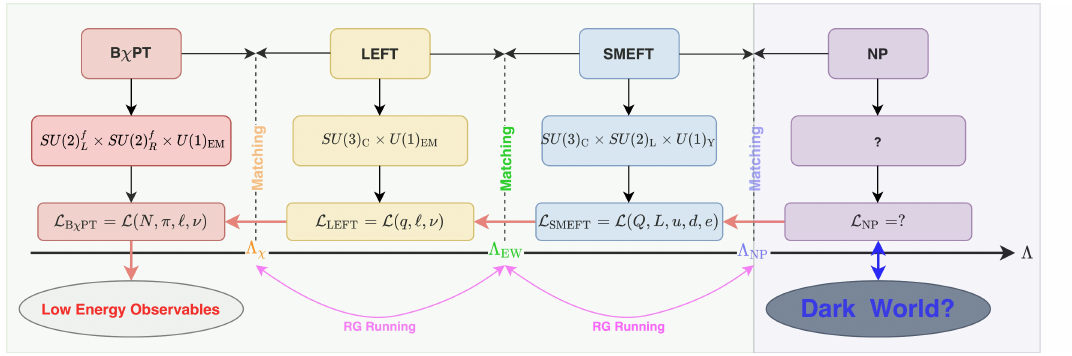
Figure 1 . The flow chart for an EFT calculation of the low energy